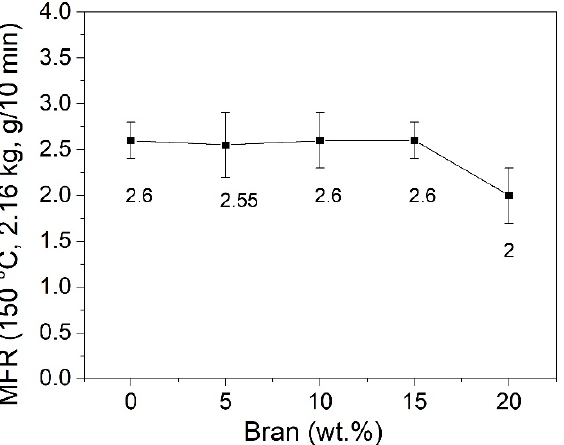
Figure 4. MFR values obtained at 150 °C for the virgin PBSA and PBSA/B composites (B5, B10, B15, and B20). Mean values ± standard deviations of three replicates.